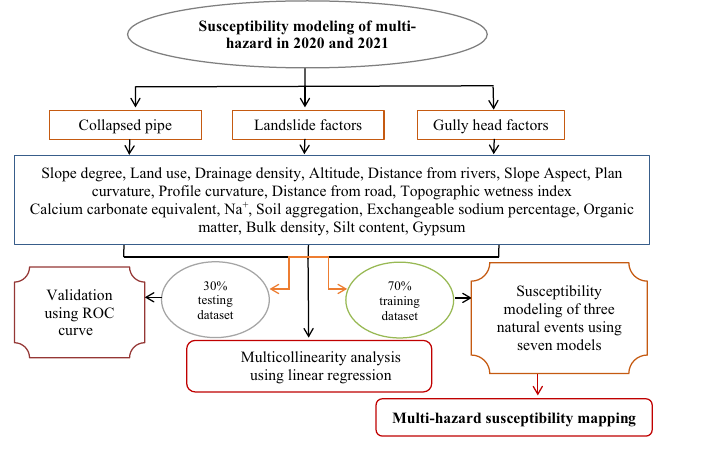
Figure 6. Methodology, approach and its